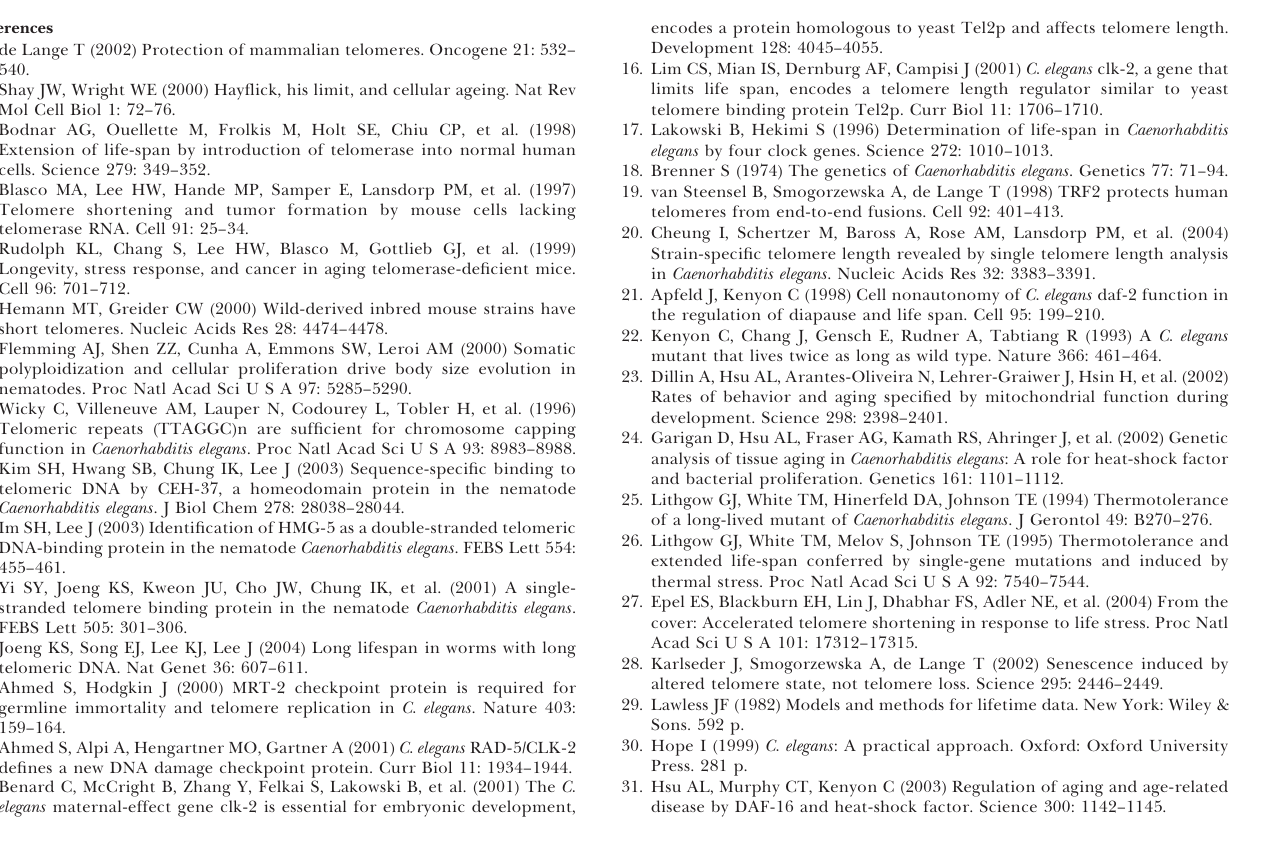
Table S1. Survival, Average and Maximal Telomere Length of Control daf-2(e1370) Mutants and daf-16(mu86) Mutant Clones Found at DOI: 10.1371/journal.pgen.0010030.st001 (52 KB